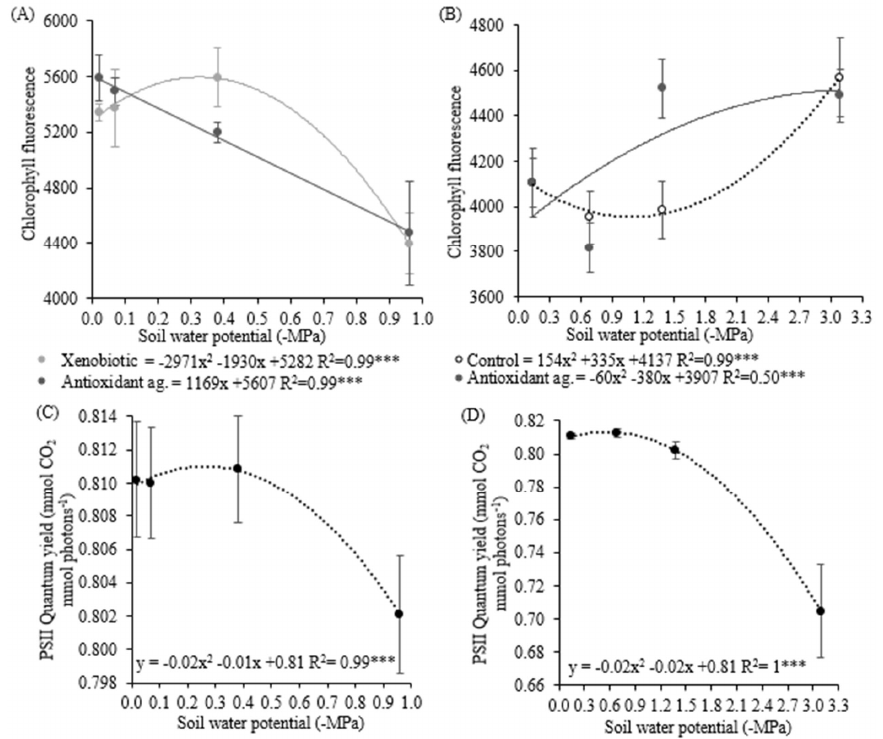
Figure3. Chlorophyllfluorescenceinthefirstexperiment( A )andthesecondexperiment( B ),quantumyield of photosystem II in the first experiment ( C ), and the second experiment ( D ) in soybean plants under different soil water potentials, and xenobiotic and antioxidant agent application. Note: asterisks indicate error probability as * = 10%, ** = 5%, and *** = 1%, respectively. Vertical bars represent the standard error of the